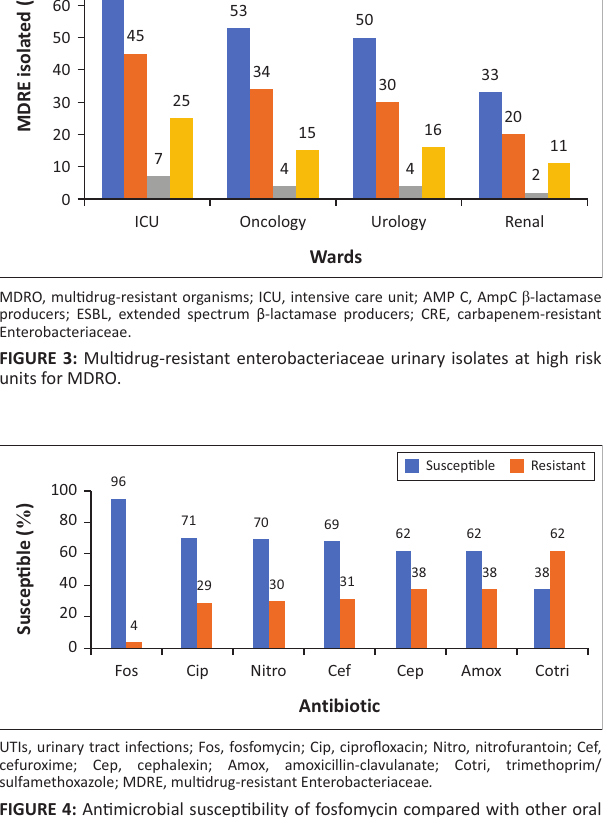
FIGURE 4: Antimicrobial susceptibility of fosfomycin compared with other oral antibiotics used to treat Enterobacteriaceae causing urinary tract infections (including multidrug-resistant Enterobacteriaceae